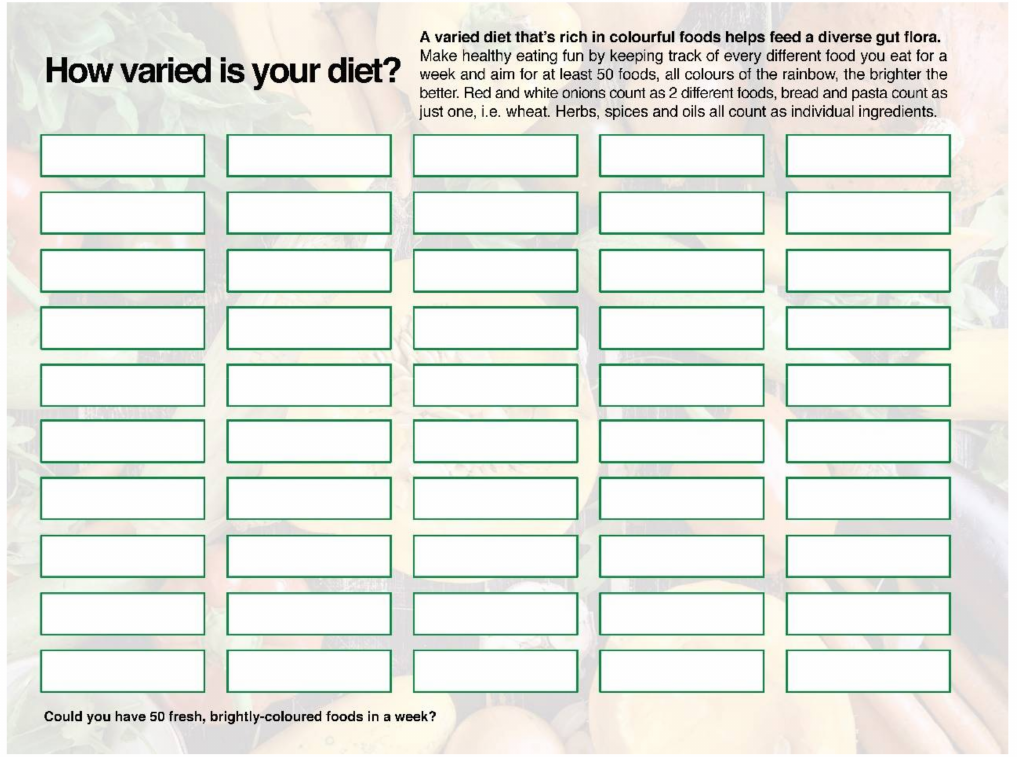
Figure 3. The author’s “50-food challenge” chart is an example of a simple, but powerful data collection tool used in clinical practice to engage with patients in a light-hearted way so that they report back to their practitioner on their dietary diversity. The rationale is to motivate patients to vary the foods they have every day, so that they’re increasing their micronutrient diversity, thereby feeding different classes of gut